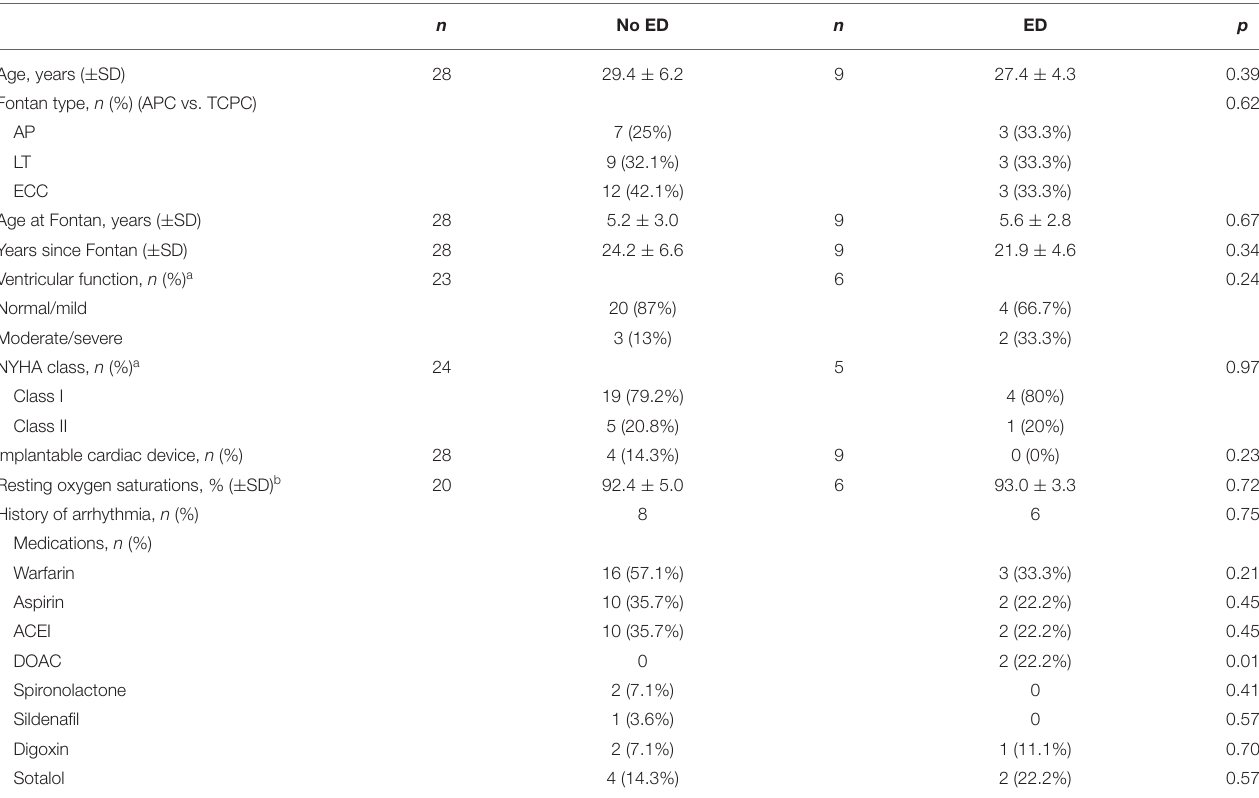
TABLE 1 | Baseline characteristics.